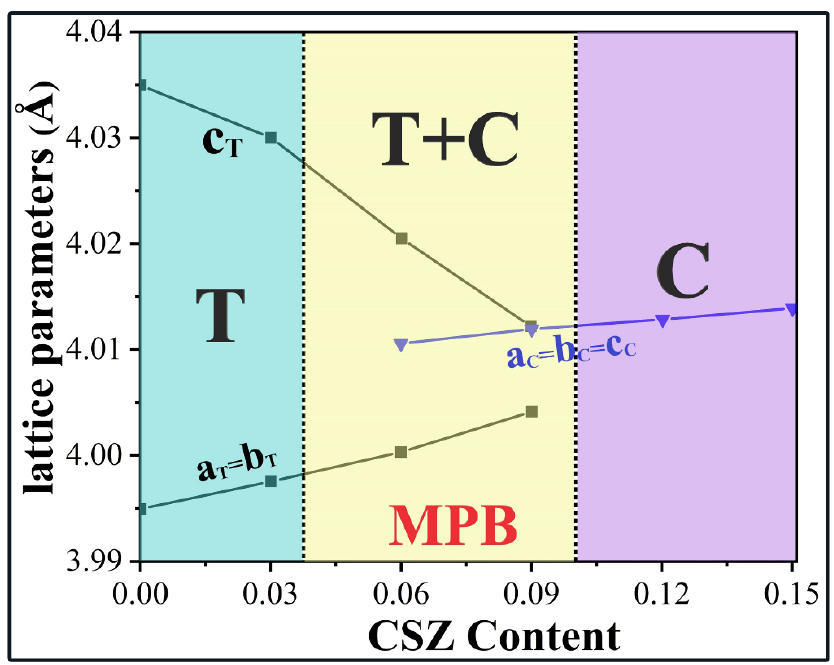
Figure 4. Variations of the crystal structure and lattice parameters as a function of CSZ content for the (1 − x )BT- x CSZ ceramics at room temperature.